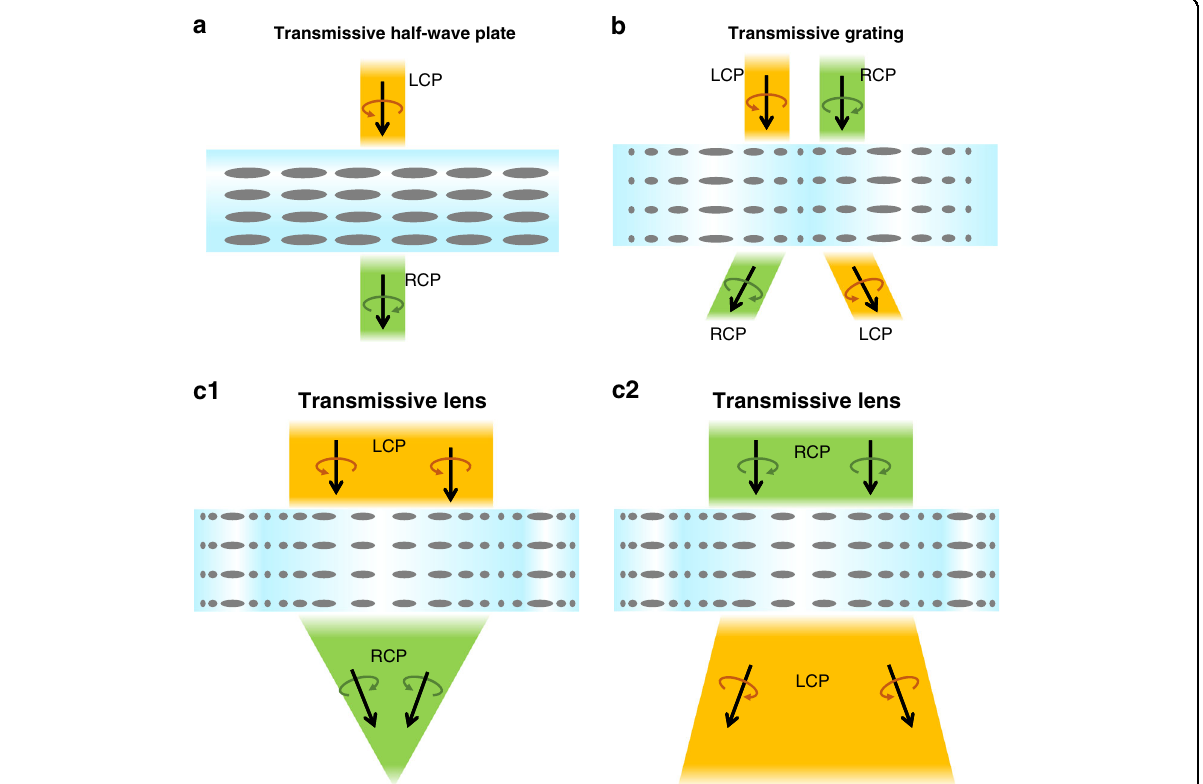
Fig. 8 Diagrams of polarization responses of various transmissive LCOEs. a transmissive waveplate , b transmissive grating, and c transmissive PB lens